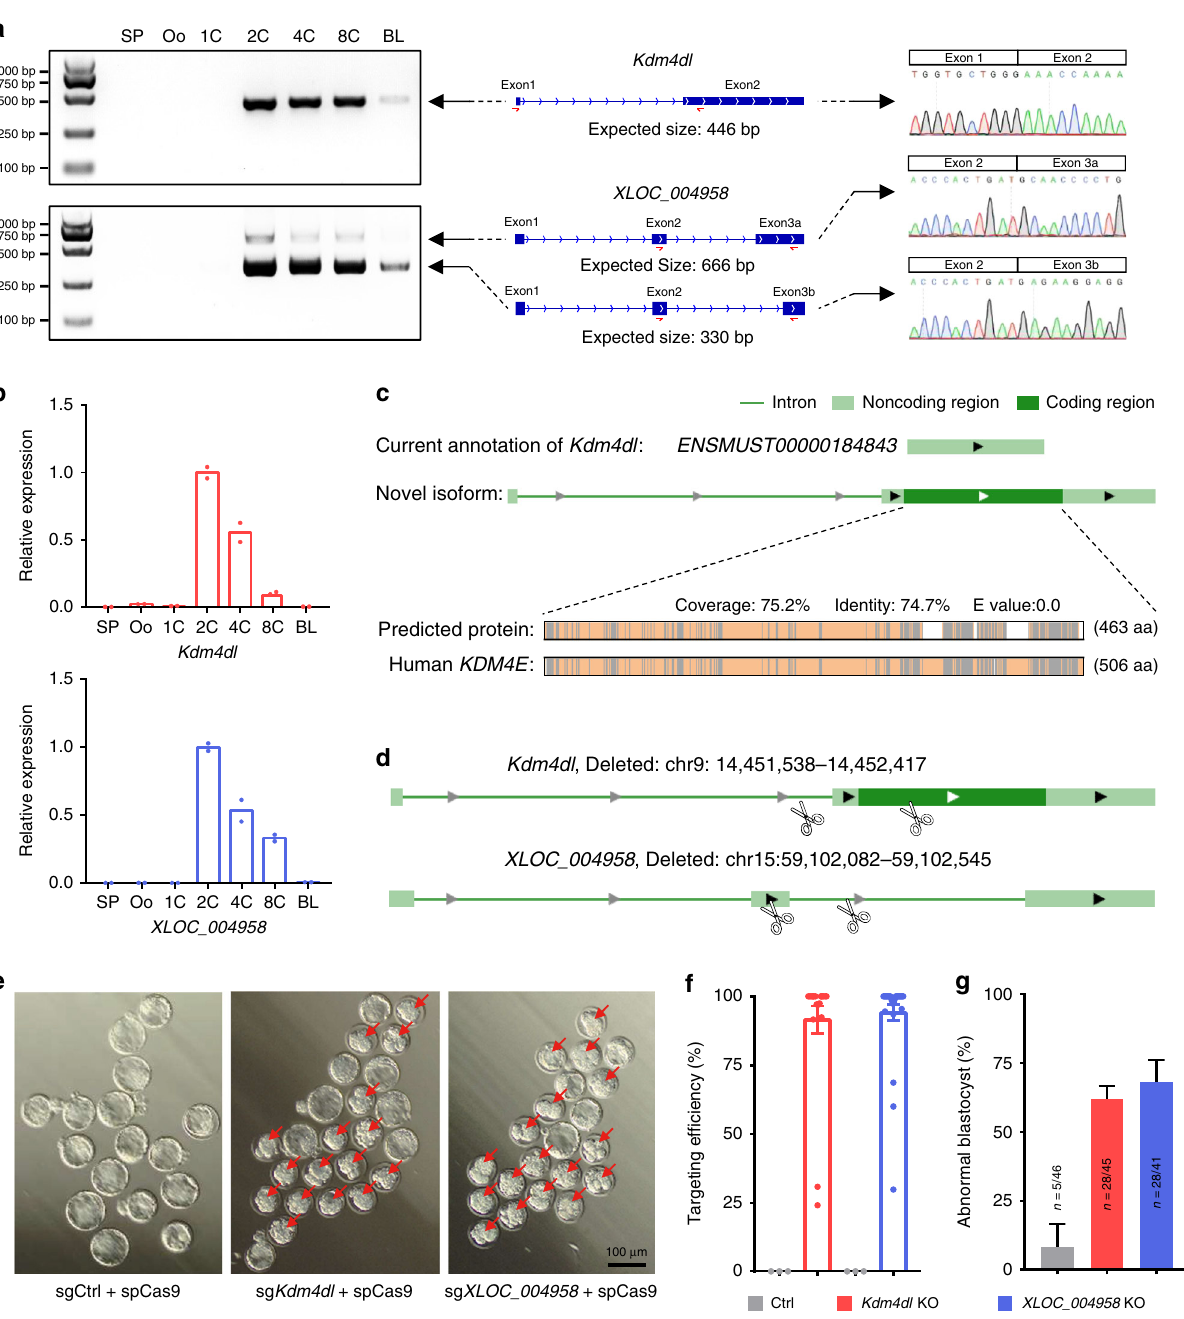
Fig. 5 Two novel transcripts functionally involved in early embryogenesis. a RT-PCR validation of Kdm4dl and XLOC_004958 during embryogenesis. The isoform structures of Kdm4dl and XLOC_004958 are shown in the middle; red arrows indicate the loci of the PCR primers, and the sizes of RT-PCR products are displayed. Sanger sequencing chromatograms of the RT-PCR products con fi rmed the splice junctions in the right panel. Representative data of two independent experiments is shown. b The relative expression of Kdm4dl and XLOC_004958 was measured by qPCR analysis. n = 2 biologically independent experiments. c Structural schematic showing the comparison of the previously annotated coding frame of Kdm4dl and the newly de fi ned coding frame of Kdm4dl according to long-read data. In the lower panel, the newly de fi ned protein sequence of Kdm4dl was compared with human KDM4E . Gray lines represent mismatched amino acids, white lines represent gaps, and light-yellow lines represent overlapping amino acids. d Diagram illustrating the CRISPR- mediated knockout of Kdm4dl and XLOC_004958 ; the scissors indicate the loci of the guide RNAs (sgRNA sequences are provided in Supplementary Table 3). e Morphological imaging of Kdm4dl and XLOC_004958 knockout embryos. The red arrows indicate abnormal blastocysts. The sgRNA-targeting GFP was de fi ned as sgCtrl. Representative data of two independent experiments is shown. f The targeting ef fi ciency of Kdm4dl and XLOC_004958 knockout embryos was calculated from Sanger sequencing results by TIDE (https://tide.deskgen.com/) and shown as the mean ± S.E.M. n = 3 embryos for Ctrl, n = 20 embryos for Kdm4dl , and n = 28 embryos for XLOC_004958 . g The proportions of abnormal blastocysts following Kdm4dl and XLOC_004958 knockout in E4.5 embryos were calculated. n = 2 biologically independent